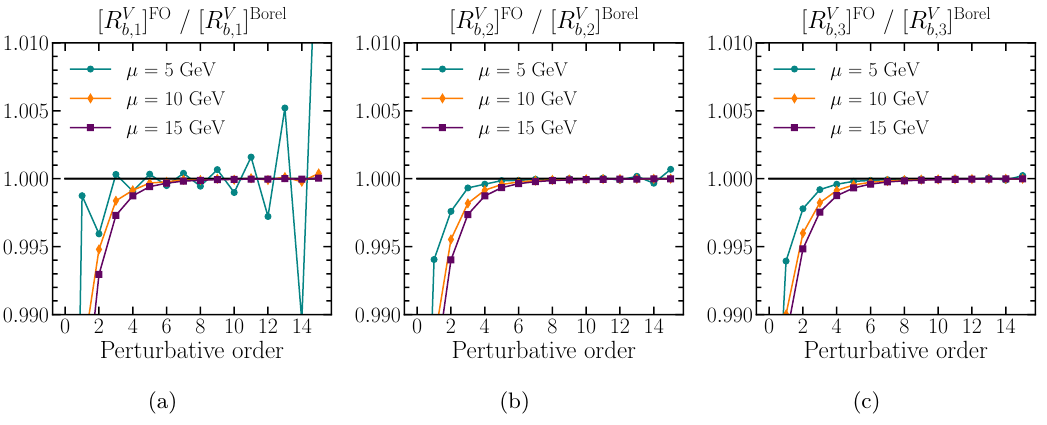
in the large- β limit 0 b,n